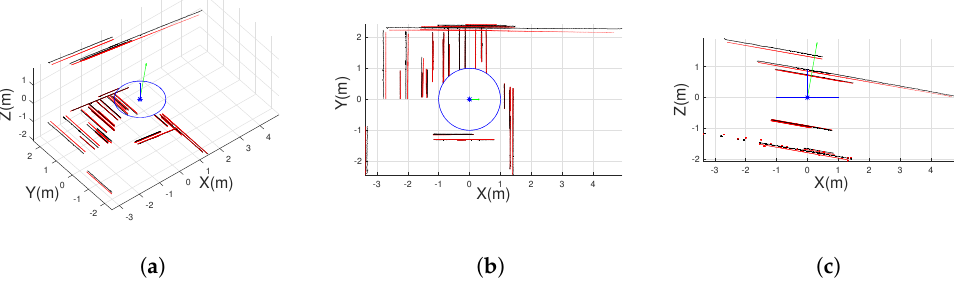
Figure 15. 3D line segments reconstructed from line extraction in non-central panorama. In red the reconstructed 3D line segments. In black the ground truth. In blue the circular location of the optical center and the Z axis. In green the axis of the vertical direction. ( a ) Orthographic view. ( b ) Top view. ( c ) Lateral